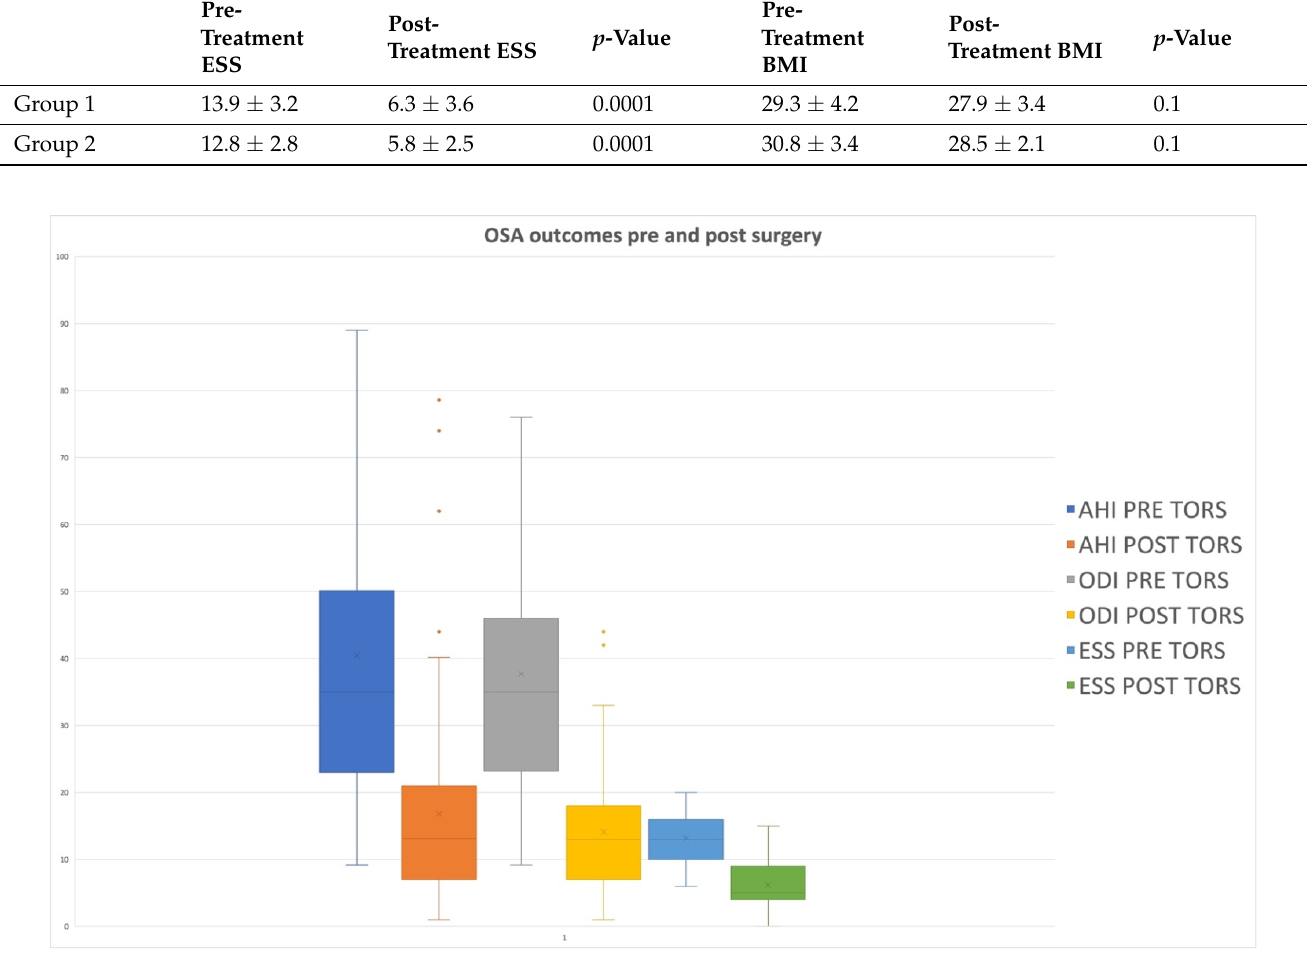
Figure 2. Box plot showing differences in OSA outcomes pre- and post-CPAP treatment. Apnea Hypopnea Index (AHI); oxygen desaturation index (ODI); Epworth Sleepiness Scale (ESS).